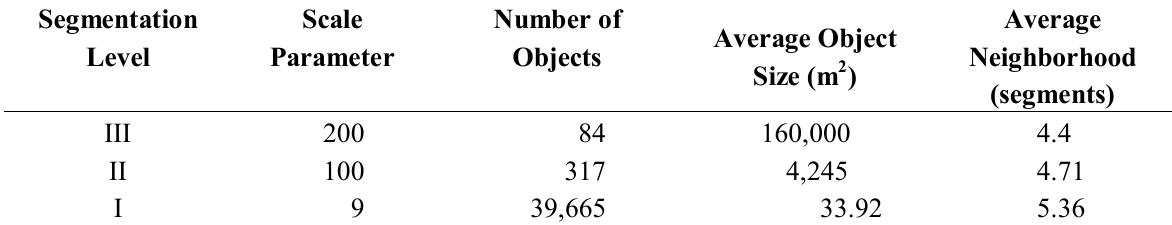
Table 1. Scale parameters at the three segmentation levels and associated object